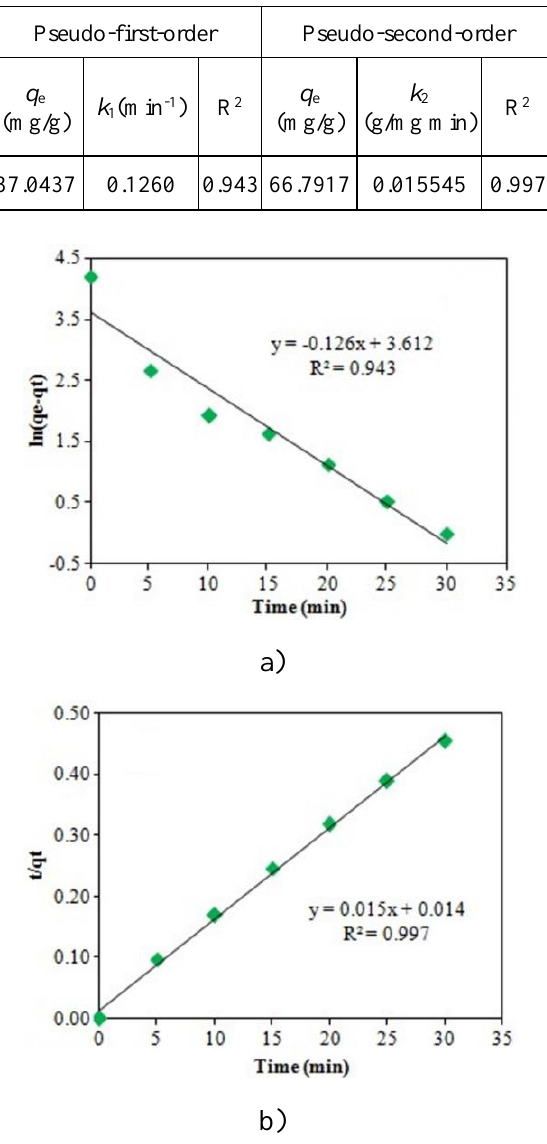
Table 1. Comparison of kinetic parameters for the adsorption of trinitrophenol (TNP) from solution onto PANI-TWC at pH = 6